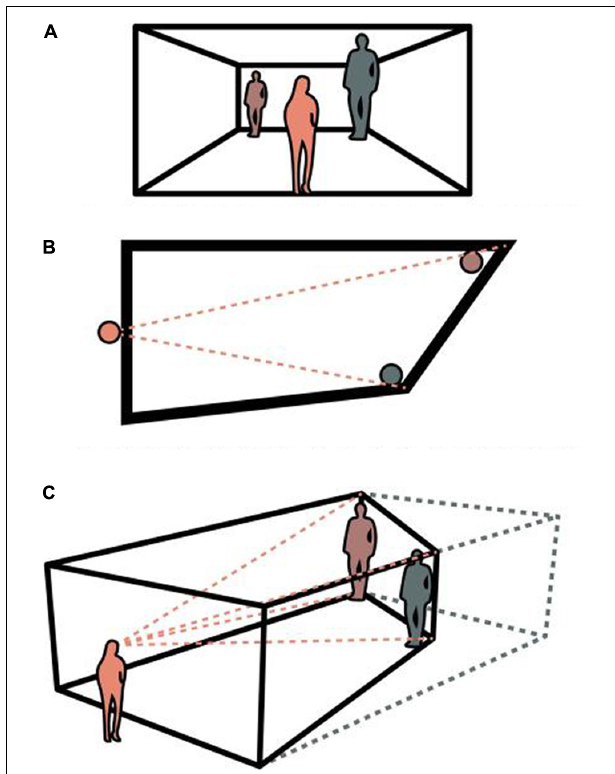
FIGURE 1 | A sketch of the Ames Room. (A) Displays what the perceiver encounters from a given point. Color-codes are used throughout the diagrams. (B) Displays a conceptual plan-drawing of an Ames Room. The red dashed lines represent the field of view of the perceiver. (C) Reveals the actual conditions under which an Ames room functions. The red dashed lines represent the field of view of the perceiver, while the blue dashed lines represent the outline of a rectangle, which the Ames room illusion suggests to exist from a specific angle (A)